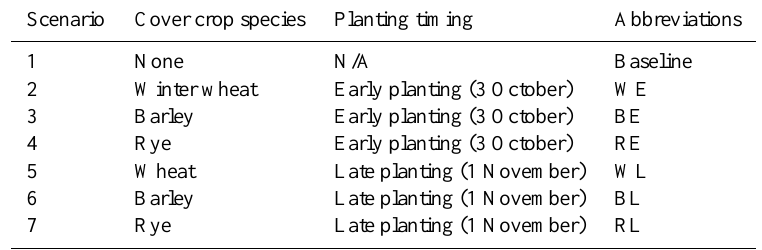
Table 3. List of cover crop scenarios.